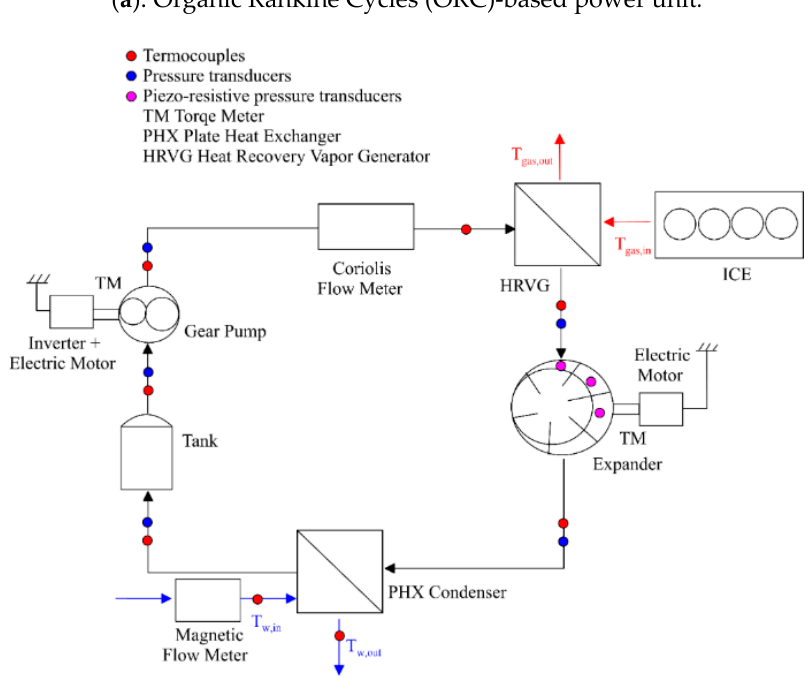
Figure 4. Experimental ORC-based power unit test bench ( a ) and scheme of sensors layout ( b ).